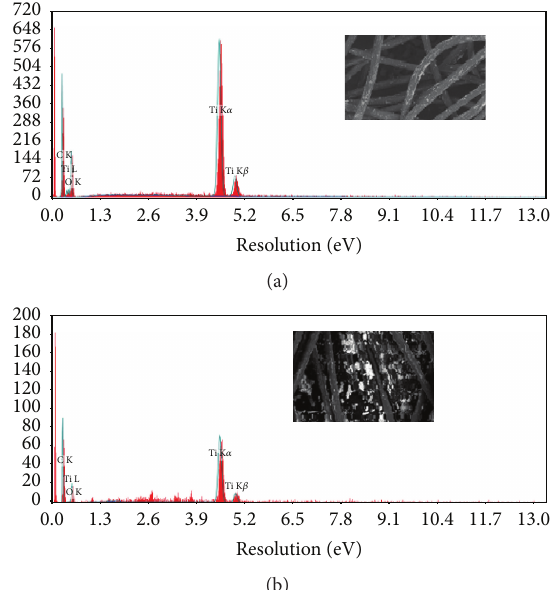
Figure 8: EDX spectra of (a) TiO 2 coated PET and (b) solar irradi- ated TiO 2 coated